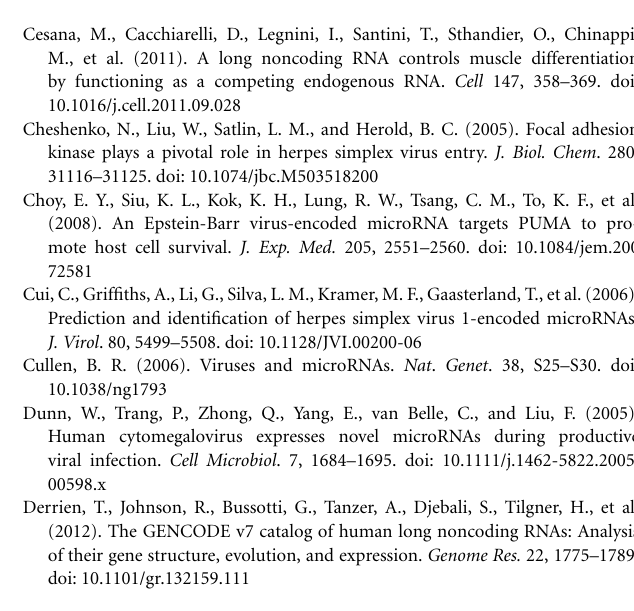
type of the chosen viral miRNA. (D) The users can search for host miRNA targets on a particular transcript from the list. The resulting page includes only interactions with the host miRNAs those are expressed cells infected with the particular virus. (E) The users can search for potential ceRNAs of a chosen host transcript. The ceRNAs may share common host or viral miRNAs expressed in virus infected